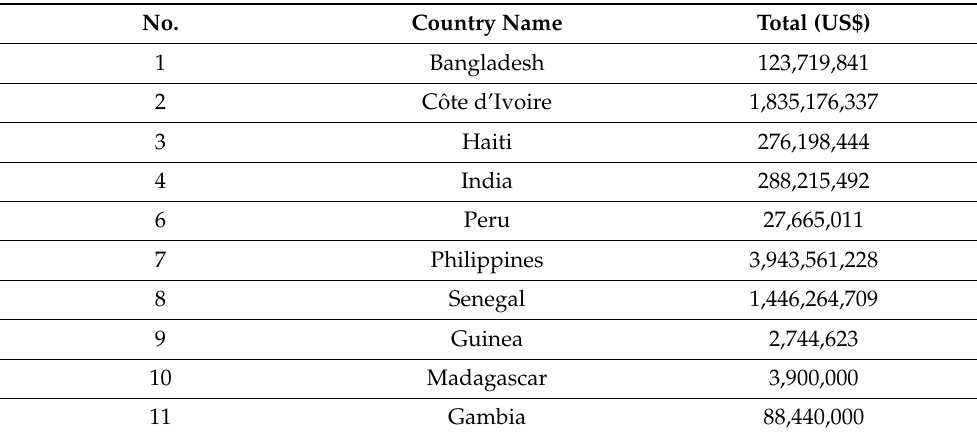
Table 3. Total costs of recovery policy (US$) in crisis countries.